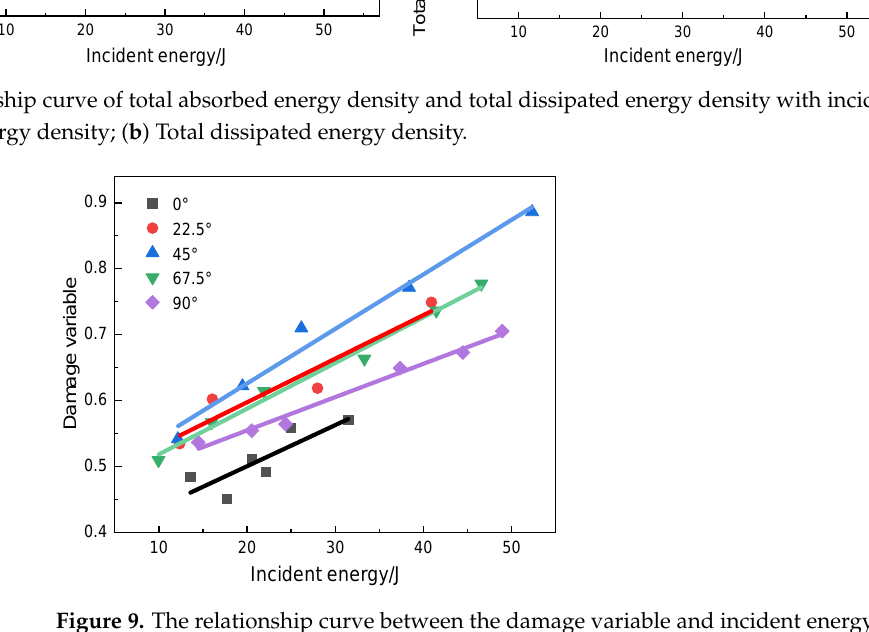
Figure 10. The relationship curve between dynamic strength and damage variable. 3.3. Characteristics of the EMR Response of Samples with Different Inclination Angles The impact dynamics experiment was based on one-dimensional stress wave theory and the assumption of uniformity, and the sample failure occurred due to stress waves. The energy carried by the incident wave minus the energy carried by the reflected wave